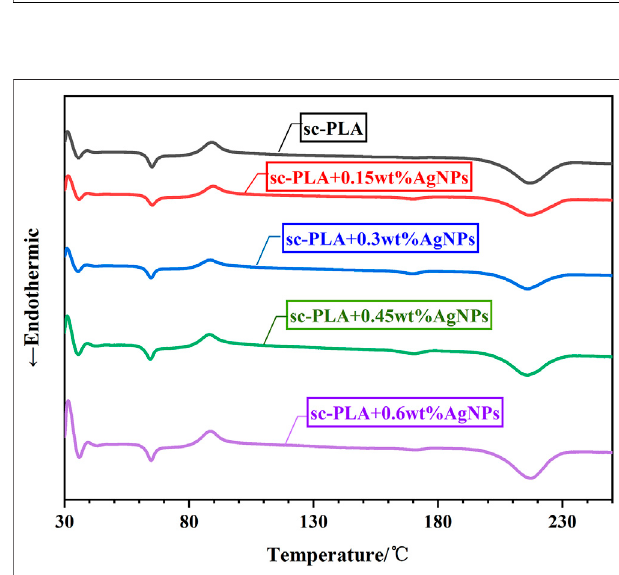
Frontiers in Materials |